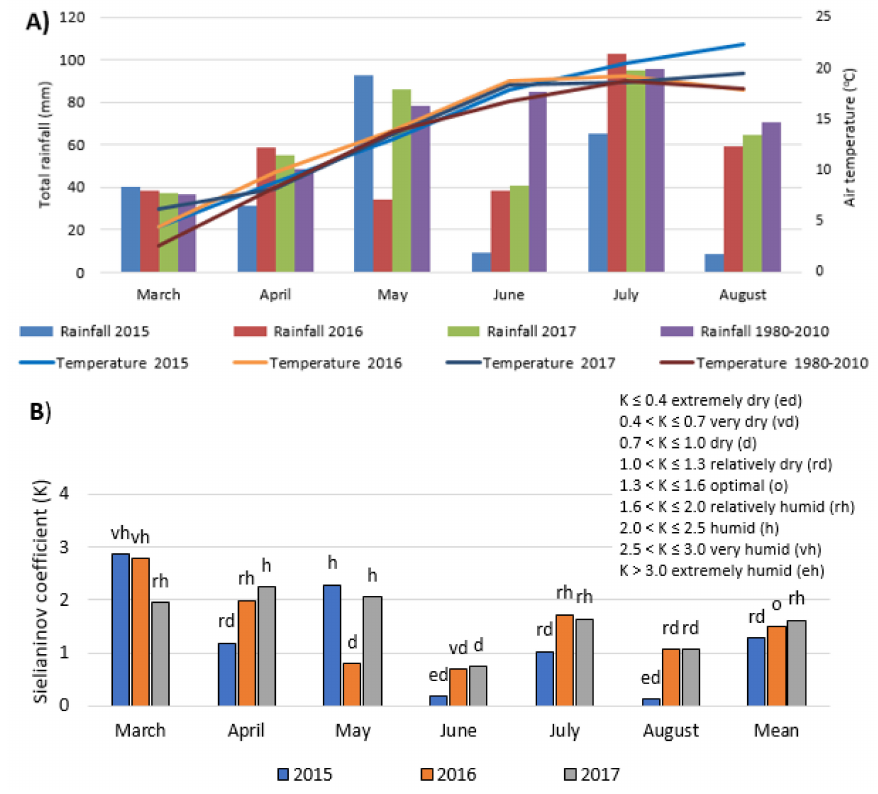
Figure 1. Meteorological conditions during pea growing season. ( A ) Monthly mean air temperature and total rainfall in 2015, 2016, 2017 and mean for 1980–2010 (data from the meteorological station of the Podkarpackie Agricultural Advisory Center, south-eastern Poland); ( B ) Hydrothermal conditions according to the Sielianinov coefficient (K)